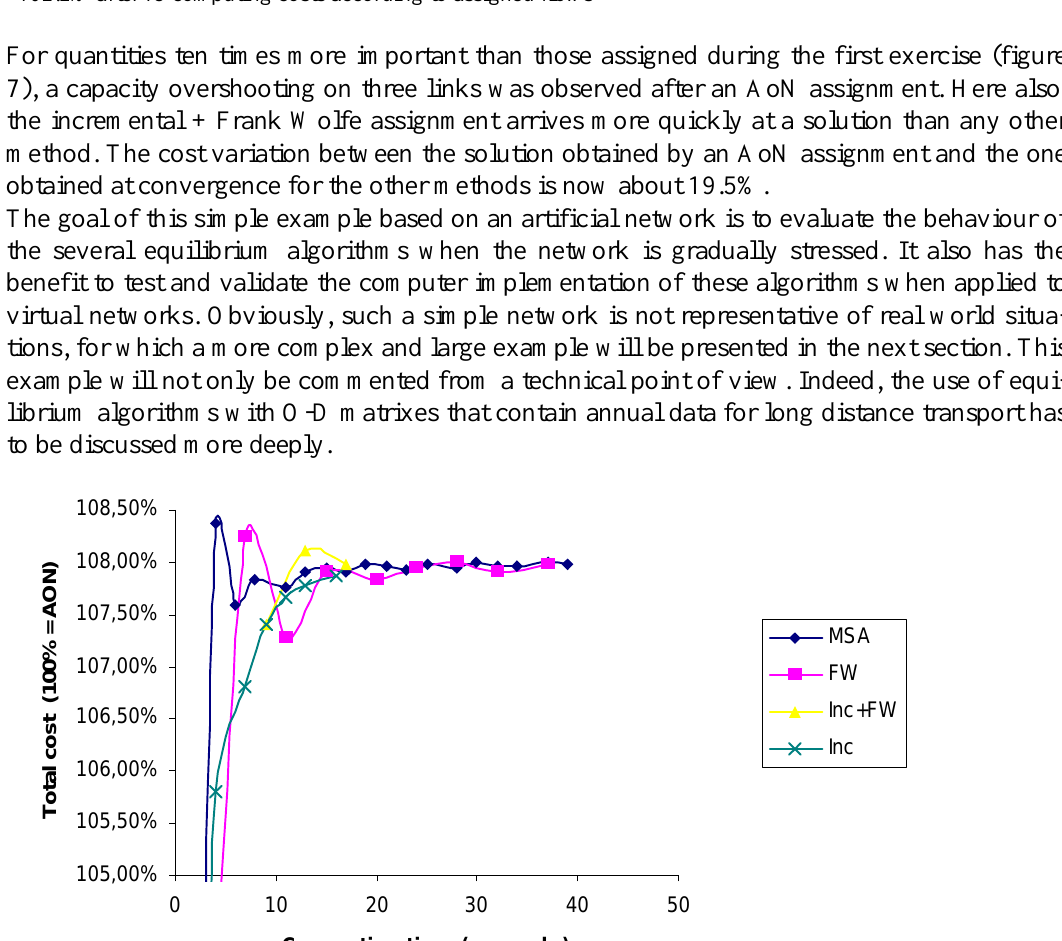
* 102.2% after re-computing costs according to assigned flows